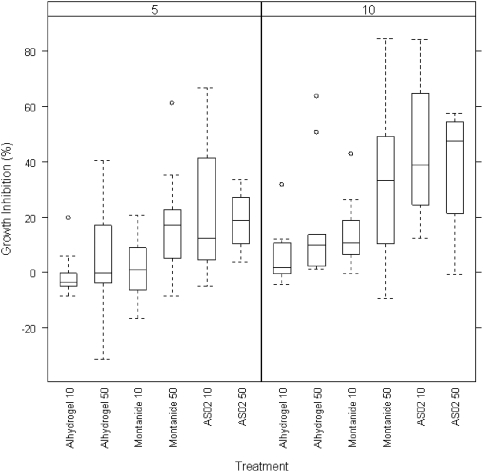
Percentage of growth inhibition of FVO-strain P. falciparum parasites after addition of 5 or 10 mg/ml IgG.Serum samples from volunteers immunised with PfAMA1 were obtained four weeks after the final immunisation by per protocol analysis and included in a merozoite growth inhibition assay. Growth inhibition is expressed as a percentage to control.Boxes show 25th, 50th and 75th percentile growth inhibition, whiskers show the range, circles are outliers.